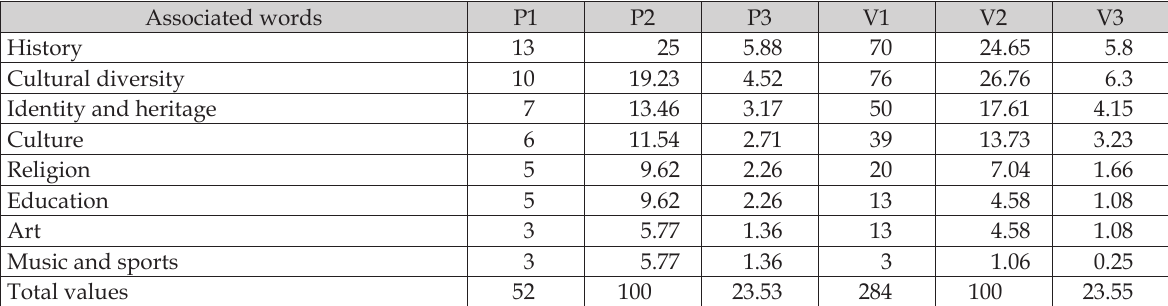
Table 5. Categories shaping the semantic field on historical and cultural realities and interpretations after an associated word test on students in training to be teachers in secondary